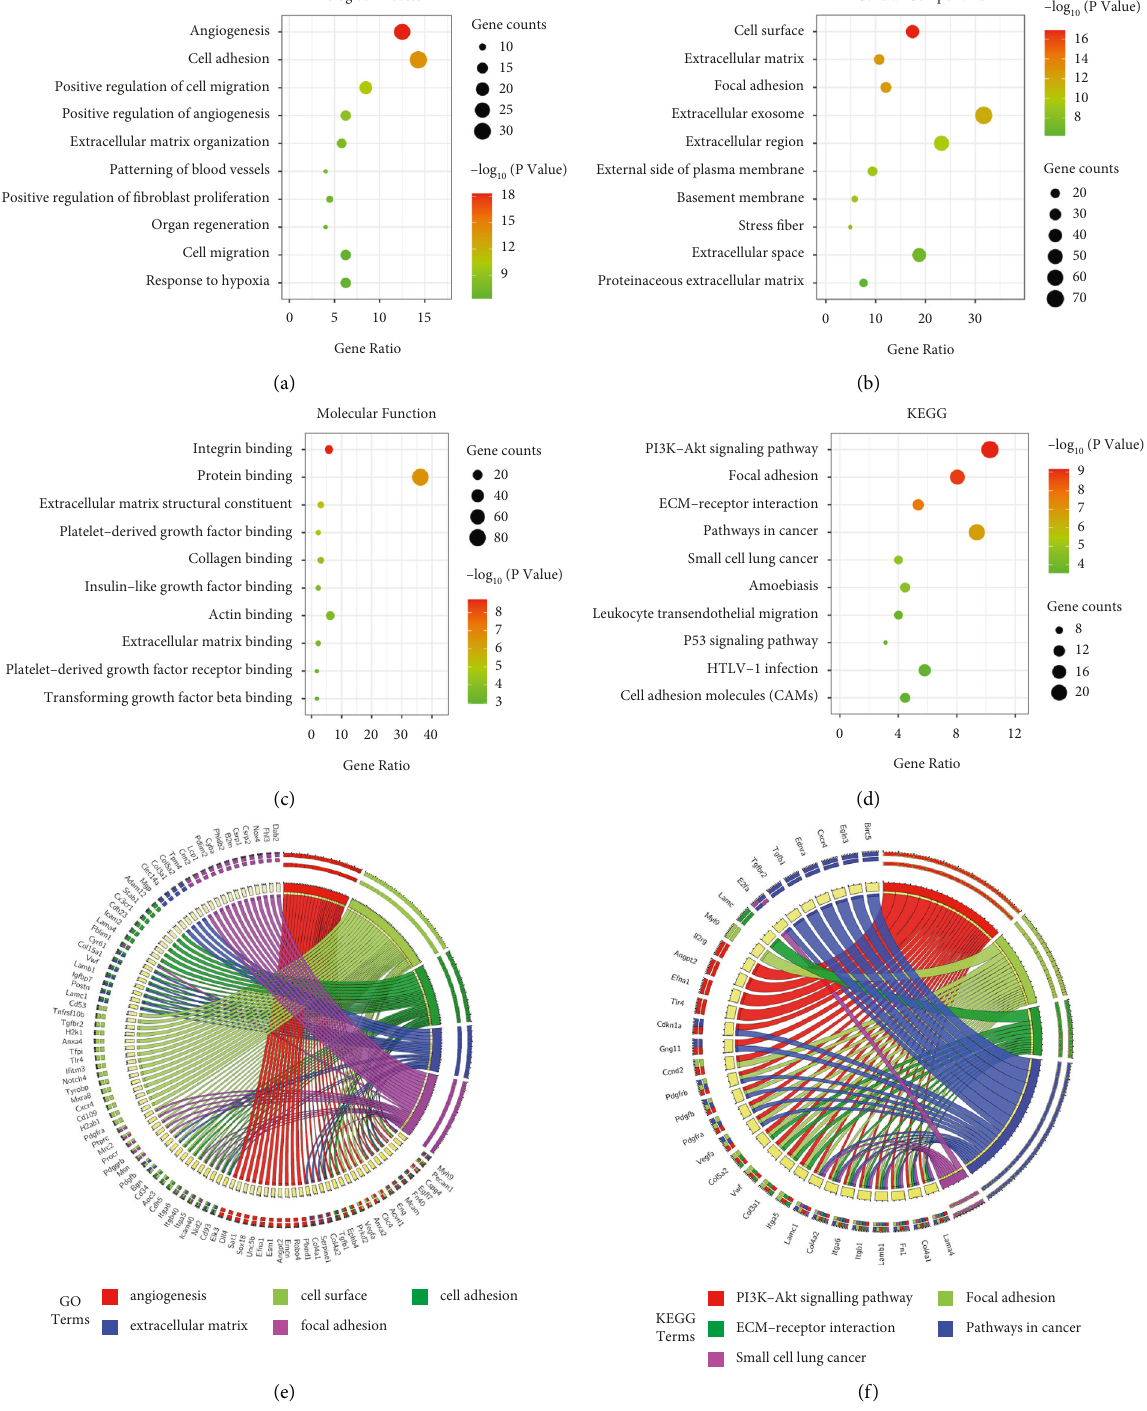
Figure 3: Gene Ontology (GO) and Kyoto Encyclopedia of Genes and Genomes (KEGG) enrichment analysis of differentially expressed genes (DEGs). The advanced bubble chart shows enrichment significance items of DEGs: (a) molecular function (MF), (b) biological processes (BP), (c) cell composition (CC), and (d) KEGG. The x -axis label represents the gene ratio, and the y -axis label represents GO or KEGG terms. The chord plot shows the distribution of DEGs in different (e) GO-enriched functions and (f) KEGG-enriched pathways. The size of the circle indicates the number of enriched